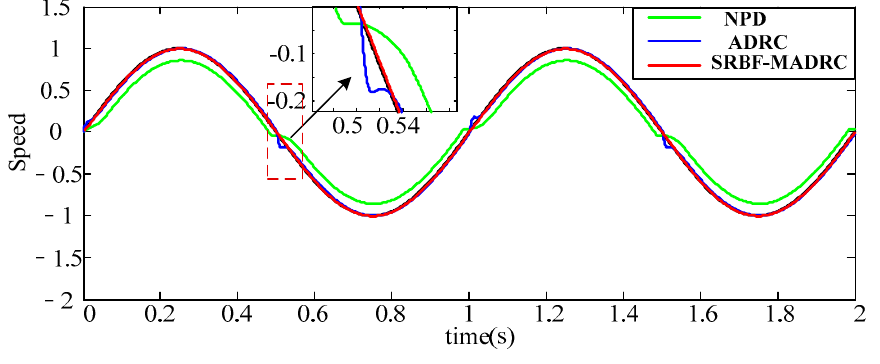
Figure 8. Simulation results of sinusoidal speed-tracking.